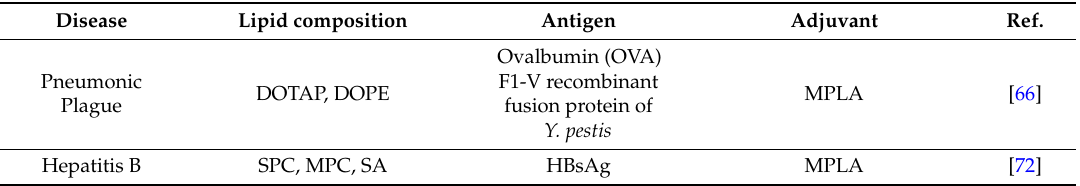
Table 2. Recent advancements in liposomal vaccine carrier